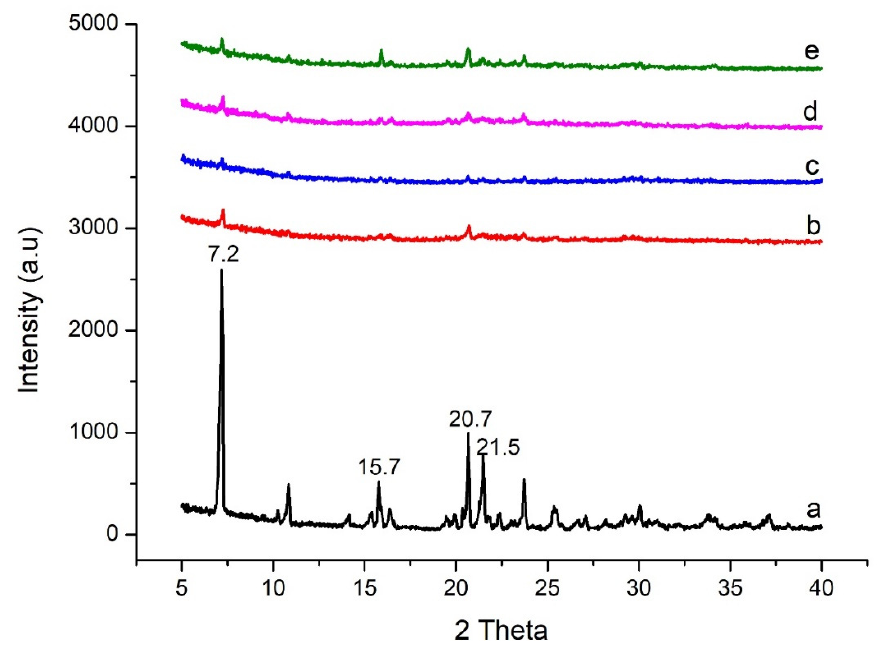
Figure 3. ( a ) Flurbiprofen, ( b ) S1, ( c ) S6, ( d ) S7, and ( e ) S12.